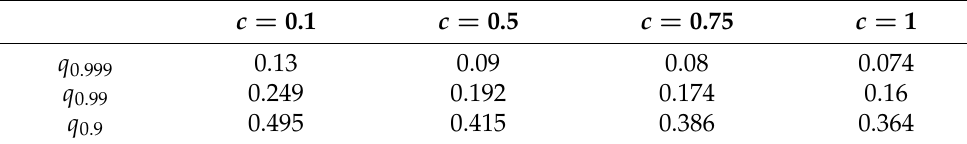
Table 2. Quantiles of reliability function.